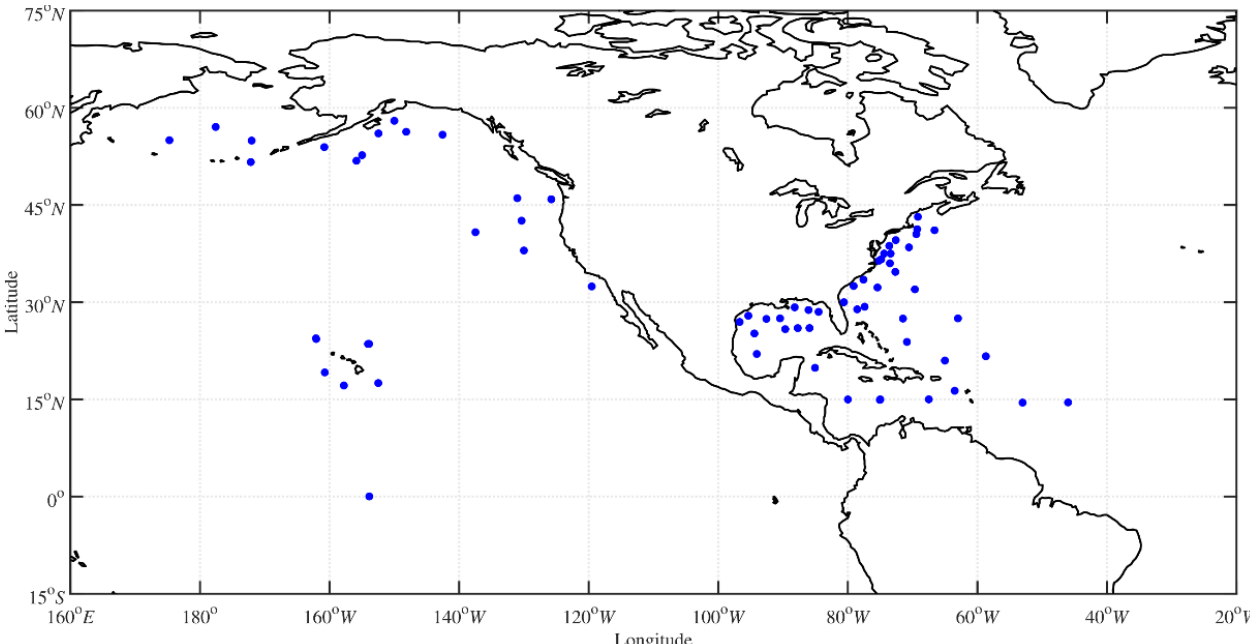
Figure 2. NDBC buoy locations (blue dots) used for the “altimeter–buoy”